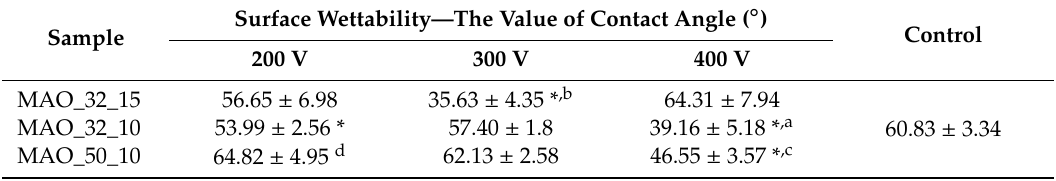
Table 4. Surface wettability of the investigated control specimens and MAO coatings with various MAO process parameters determined by the measurements of the contact angle of distilled water.